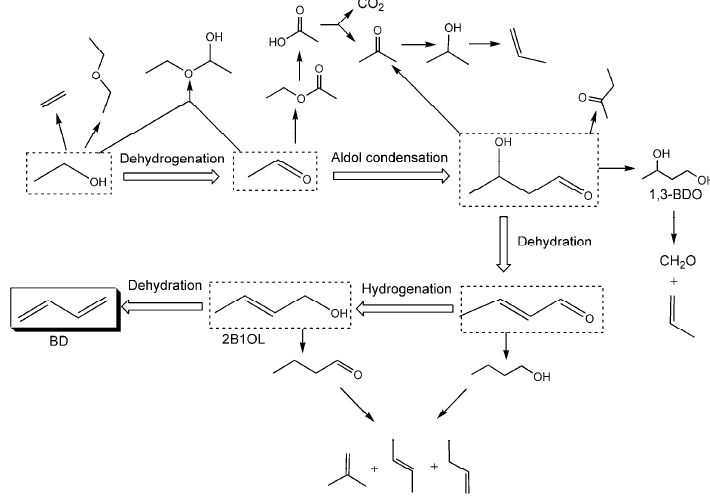
Figure 1. The general reaction mechanism and major by-products of 1,3-butadiene (BD) production from ethanol [19,23–35].